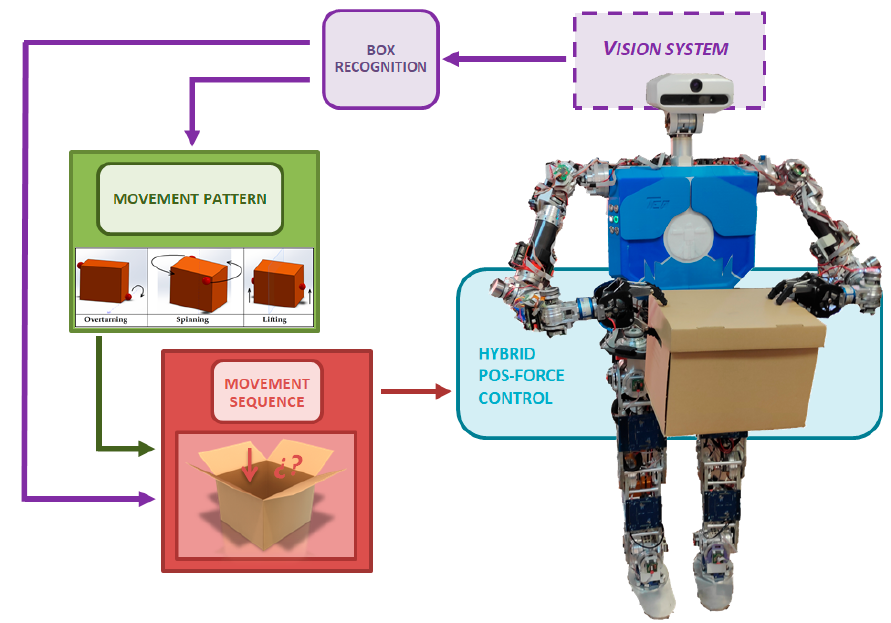
Figure 18. General application scheme.